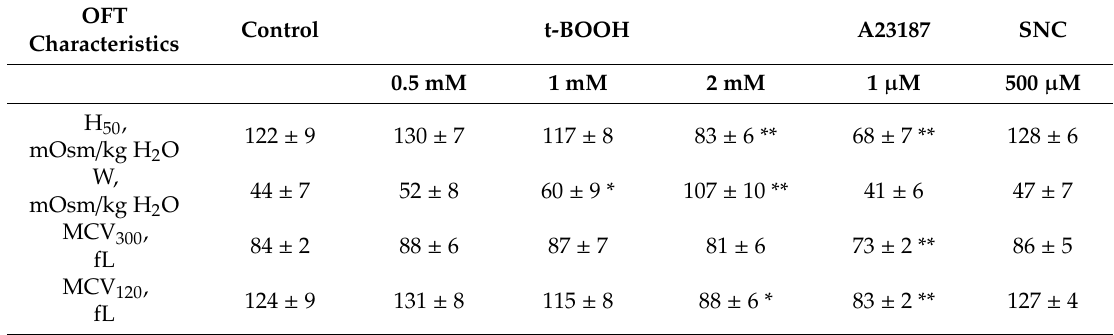
MCV 300 —data from hematology cell counter. Data are presented as means ± SD ( n = 6), one-way ANOVA; if Levene’s test < 0.05, Tamhane T2 post hoc (MCV 300 ,) was used; if Levene’s test > 0.05,